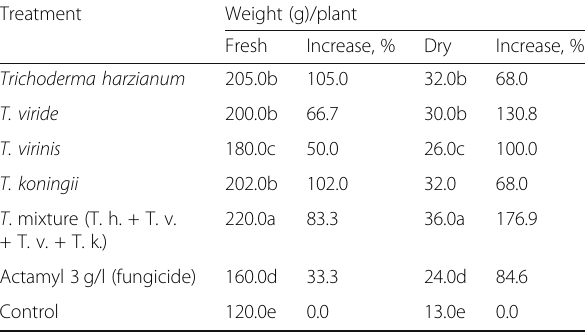
Table 3 Effect of four Trichoderma spp. on some vegetative characters of strawberry plants under field conditions Treatment